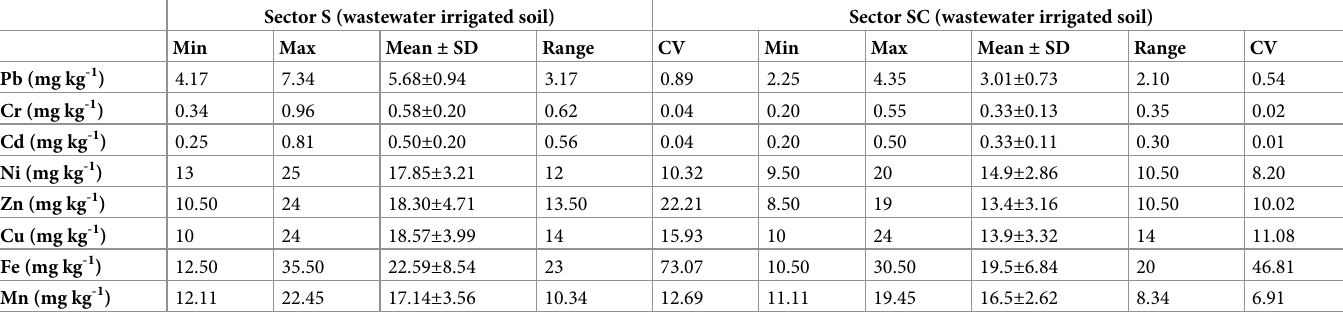
Table 3. Descriptive statistics for physicochemical properties and heavy metals concentration in soil of Swabi.